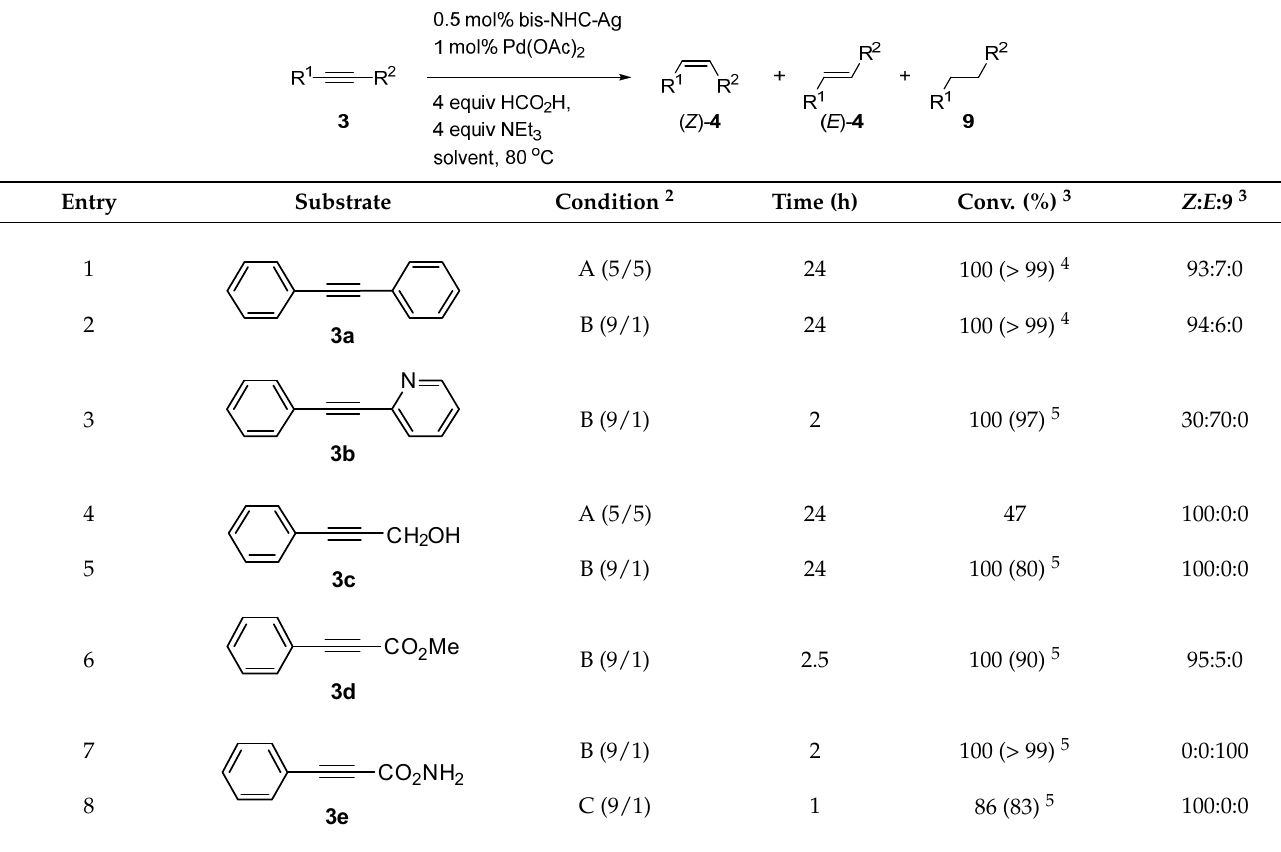
Table 4. Stereoselectivity studies for bis -NHC–Ag / Pd(OAc) 2 catalytic system catalyzed transfer hydrogenation of internal alkynes in aqueous media 1 .